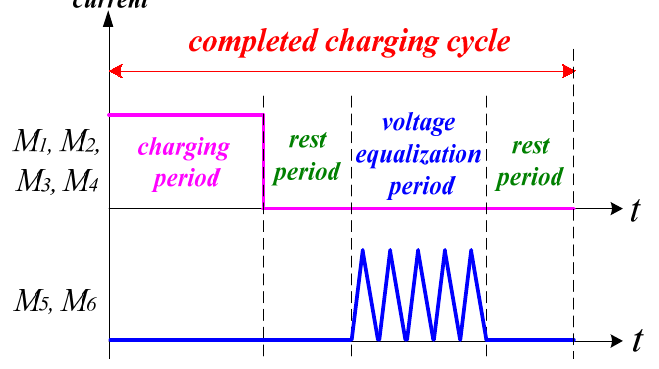
Figure 13. The proposed non-dissipative charging and voltage equalization strategies.